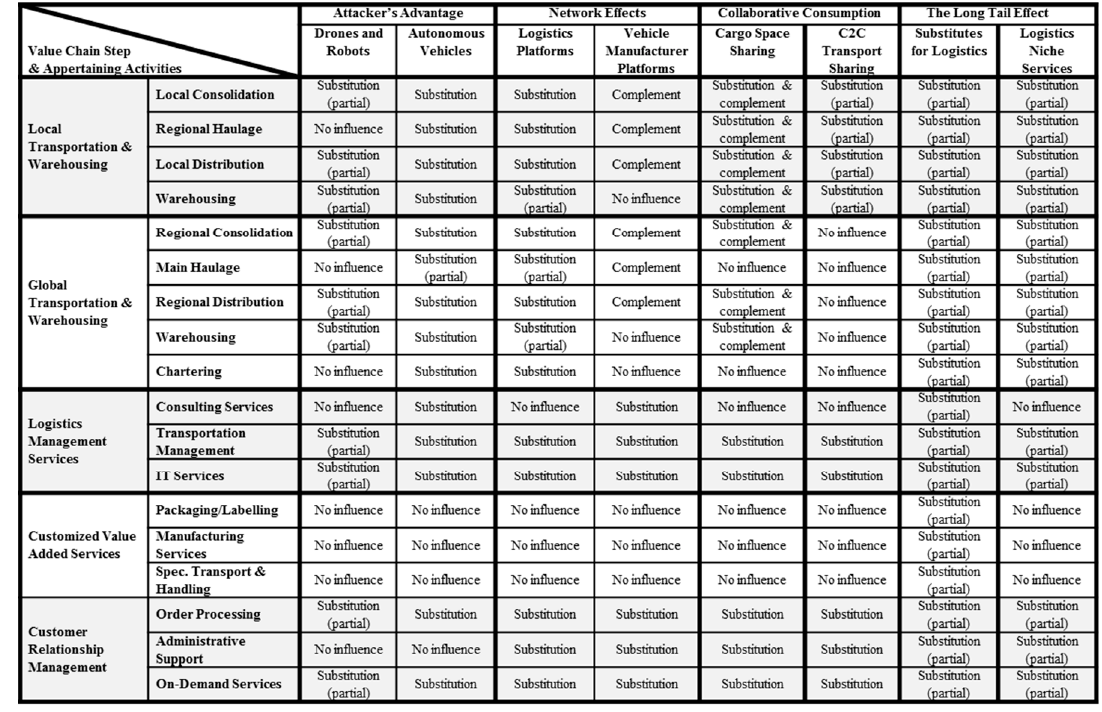
Figure 5. Impact overview of the digitalization examples on the 3PL value chain. As can be seen, local transportation and warehousing are especially likely to be substituted. The only value chain step hardly affected at all is customized value-added services.